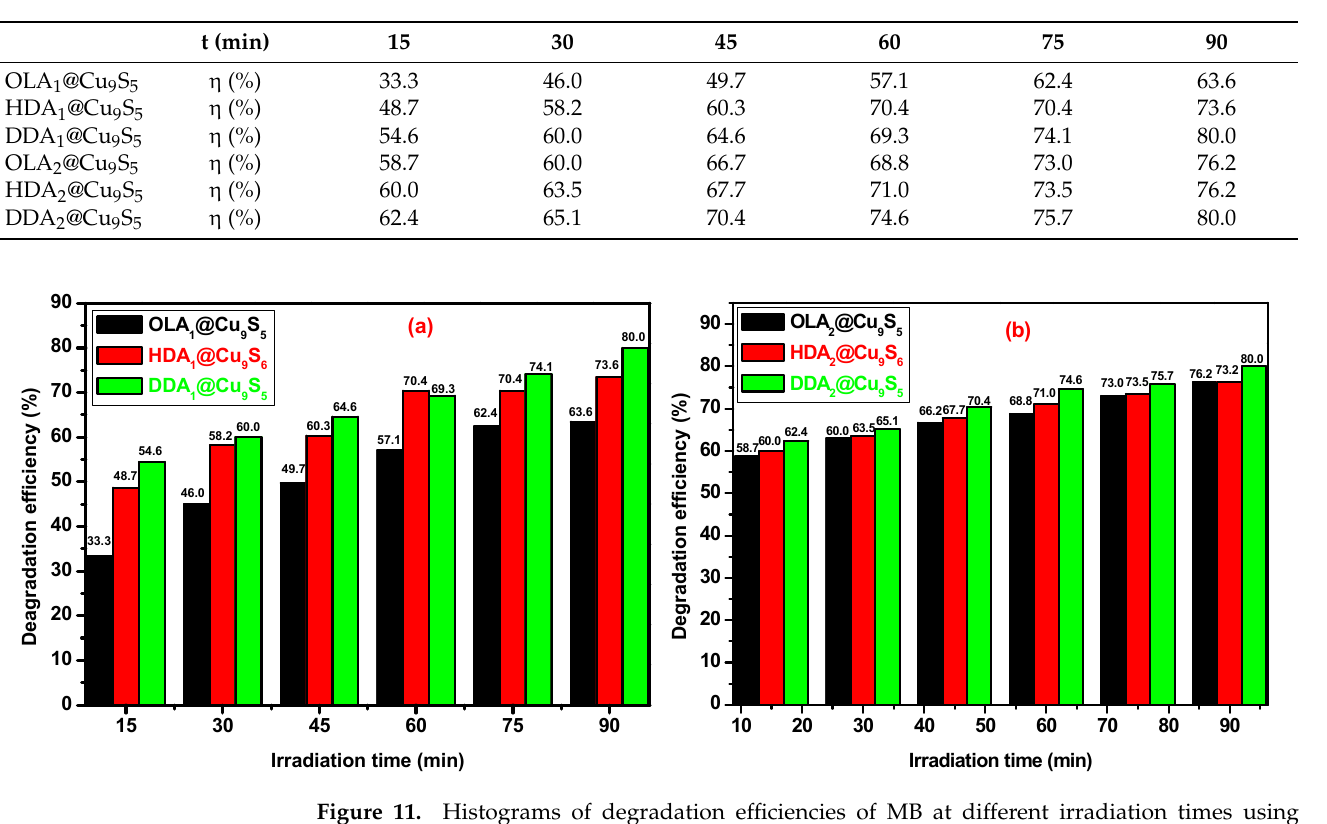
Figure 10. Degradation-efficiency curves of MB at different irradiation times using ( a ) complex 1 and ( b ) complex 2 at 190 ◦ C. Table 3. Degradation efficiencies of OLA@Cu 9 S 5 , HDA@Cu 9 S 5 , and DDA@Cu 9 S 5 NPs obtained at 190 ◦ C using complexes 1 and 2.